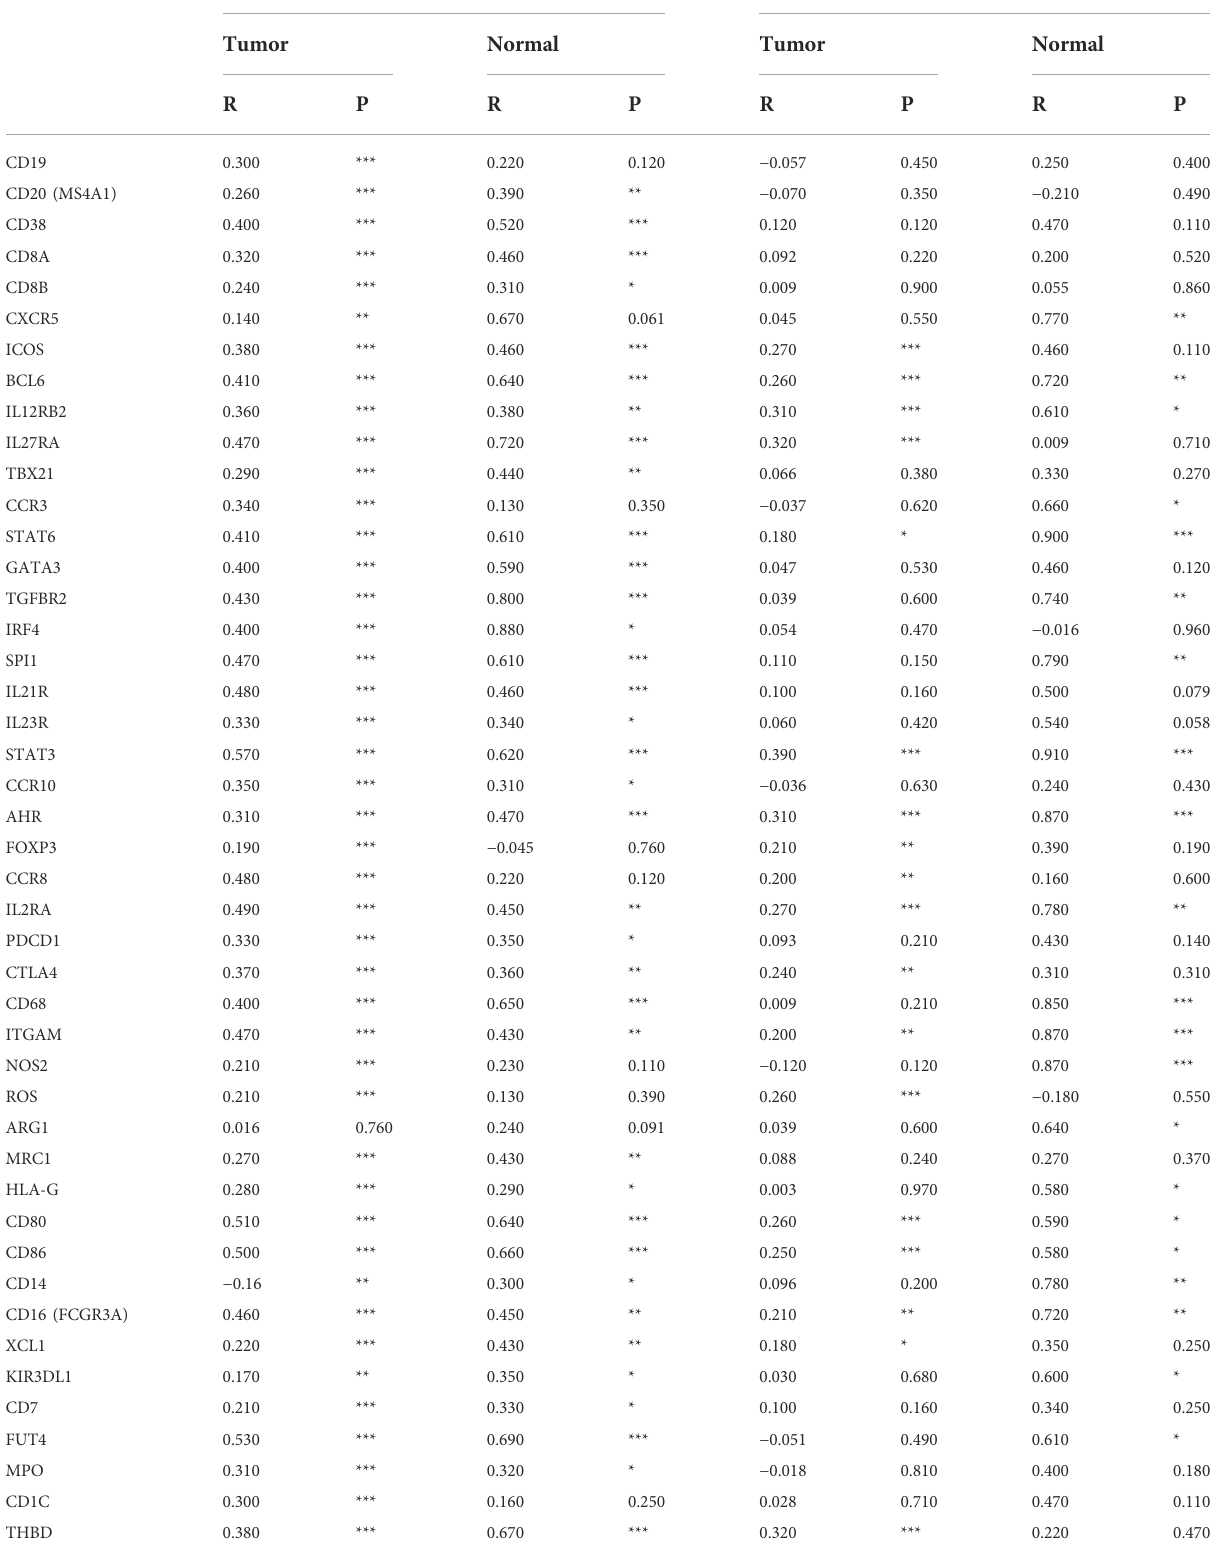
TABLE 2 Correlations between WTAP and genes markers of normal and tumor tissues of LIHC and ESCA. Gene marker